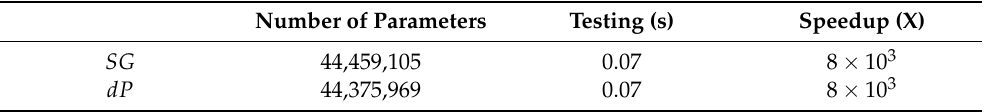
Table 3. Model size, testing speed, and rate of prediction (compared to numerical simulation speeds). Testing speeds are averaged for 500